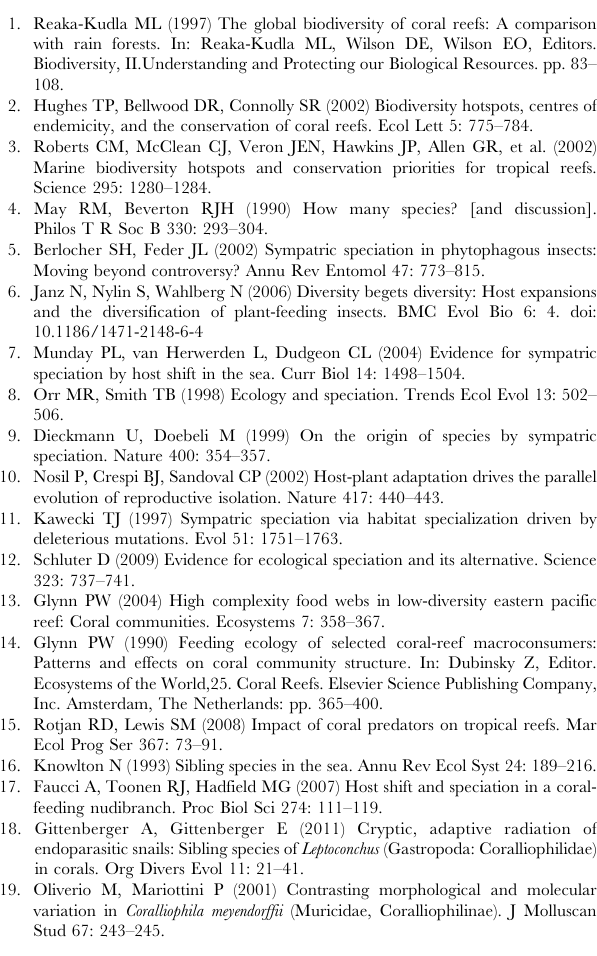
Figure S2 STRUCTURE results: mean ( ± SD) of esti- mated Ln probability of the data for each K value. Figure S3 Mismatch distribution. The observed number of pairwise nucleotide differences (open circles) for mitochondrial cyt b sequences plotted with the expected number of pairwise nucleotide differences under a model of sudden demographic expansion (solid line) and the 95% confidence intervals for the model estimation (dashed